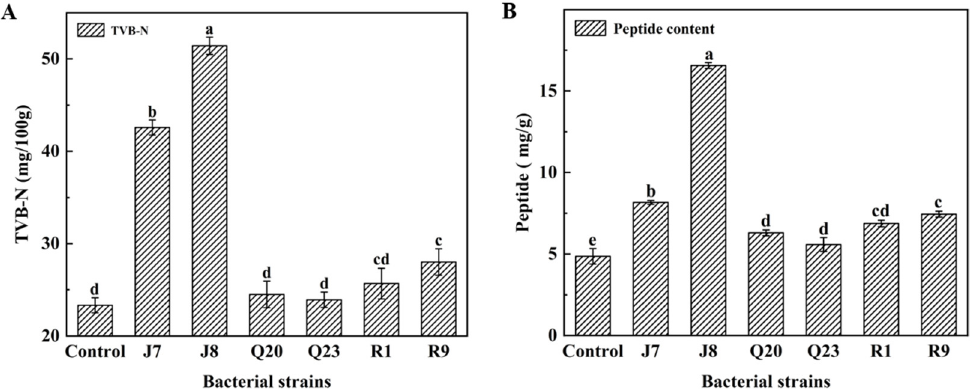
Figure 3. Peptide content ( A ) TVB-N ( B ) results at the end of storage of chicken breast samples inoculated with P. lundensis J7, P. lundensis J8, A. hydrophila Q20, A. media Q23, B. thermosphacta R1, and B. thermosphacta R9. Different lowercase letters indicate a significant difference among the samples contaminated with different bacteria for the same index.